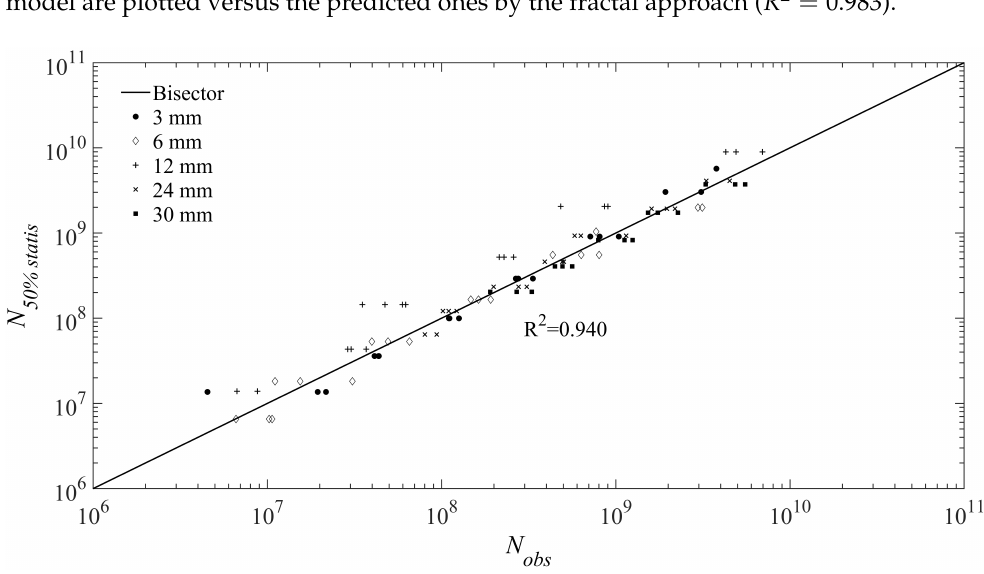
Figure 9. Median fatigue life predicted by the statistical model ( N 50% statis ) versus the experimentally observed number of cycles ( N obs ).